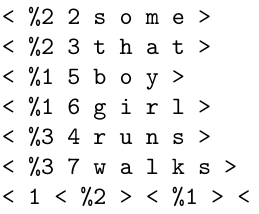
Figure 3. The best SP-grammar found by the SPCM when New contains the eight sentences described in the